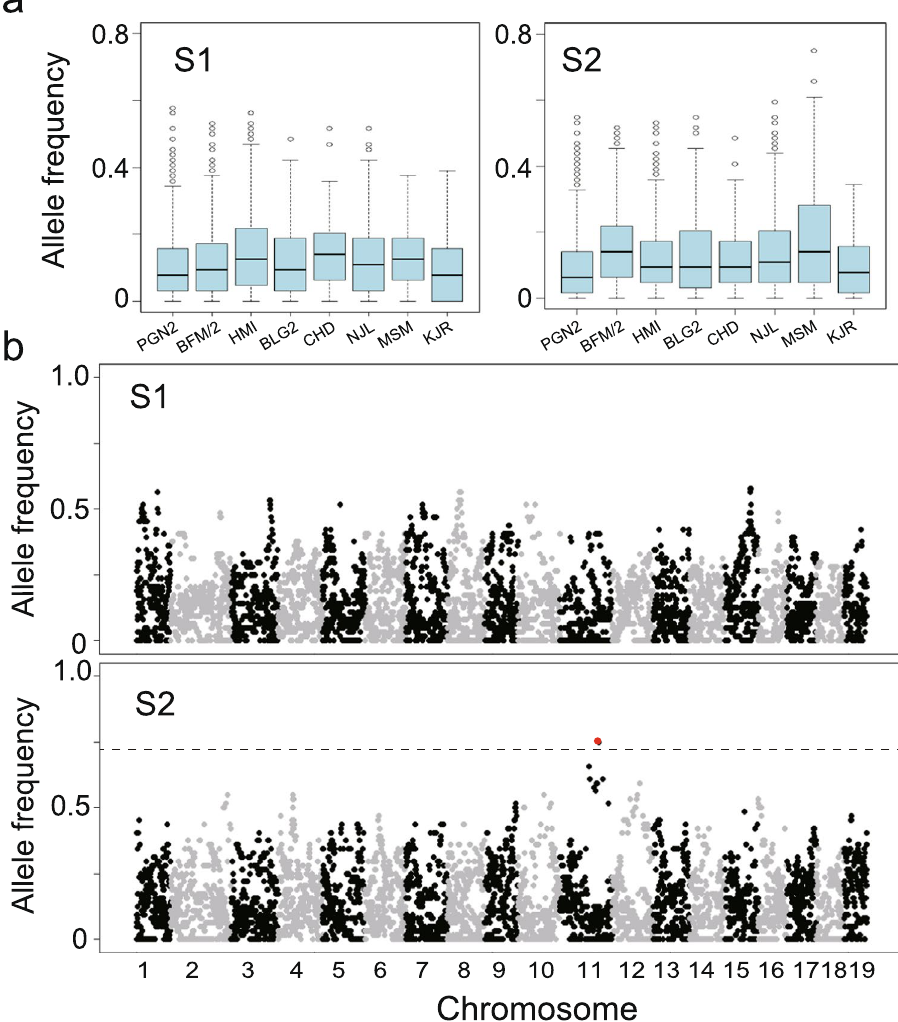
one-strain-specific SNPs in groups S1 and S2 in generation G 12 are indicated. ( b ) Selection mapping results for groups S1 and S2. For group S1, no SNP reached the threshold determined using the computer simulation described in Table S2. For the S2 group, one SNP (UNC20197962) marked with a red dot exceeded the threshold value for the MSM strain (a dashed